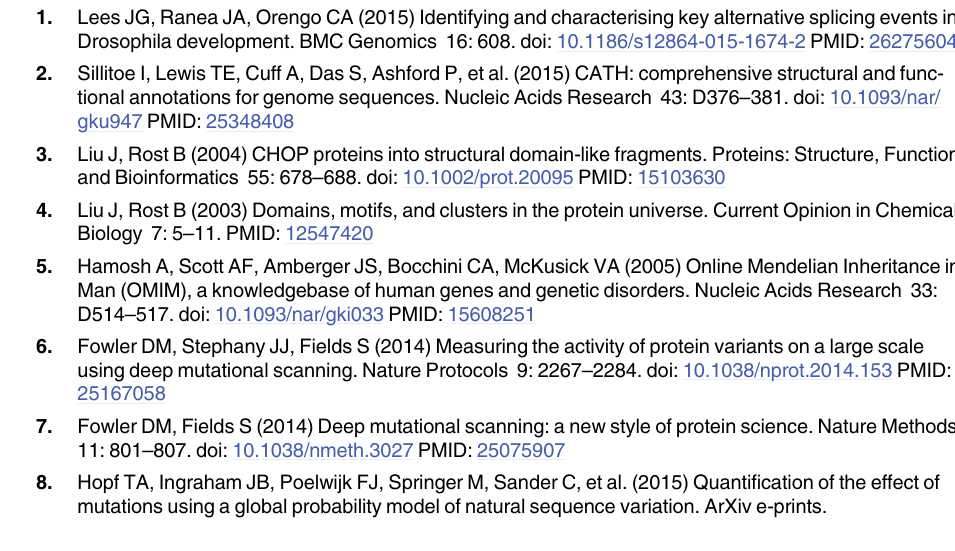
S2 Table. The set of 117 OMIA mutations. The 117 mutation extracted by manual review from the OMIA database. Shown are only entries for which a sequence could be found and the mutation mapped onto the sequence ( cf . S3 Table). All diseases are considered a defect by OMIA annotation. Organism shows the NCBI taxonomy id. Variants marked with (cid:3) , are those where the position was shifted one forward (Methods, S3 Table). The full set including the sequences is also available at rostlab.org/resources/omia. S3 Table. Attrition rate of OMIA annotations. AA deletion describes cases where a single amino acid is deleted without affecting the reading frame. Nonsense are mutations to a prema- ture stop codon. These two cases were extracted from OMIA but not used in the analysis. For the amino acid substitution set No seq . describes that no sequence was found for the given com- bination of taxonomy id and gene id (Methods). No match describes that a sequence was found but the amino acid at the position given by OMIA was not the one expected from the annotated mutation. Match are all cases where this was the case, and Match+1 were the amino acid fit after shifting one position to the right. Highlighted in green are the cases forming the final set of 117 mutations used for the